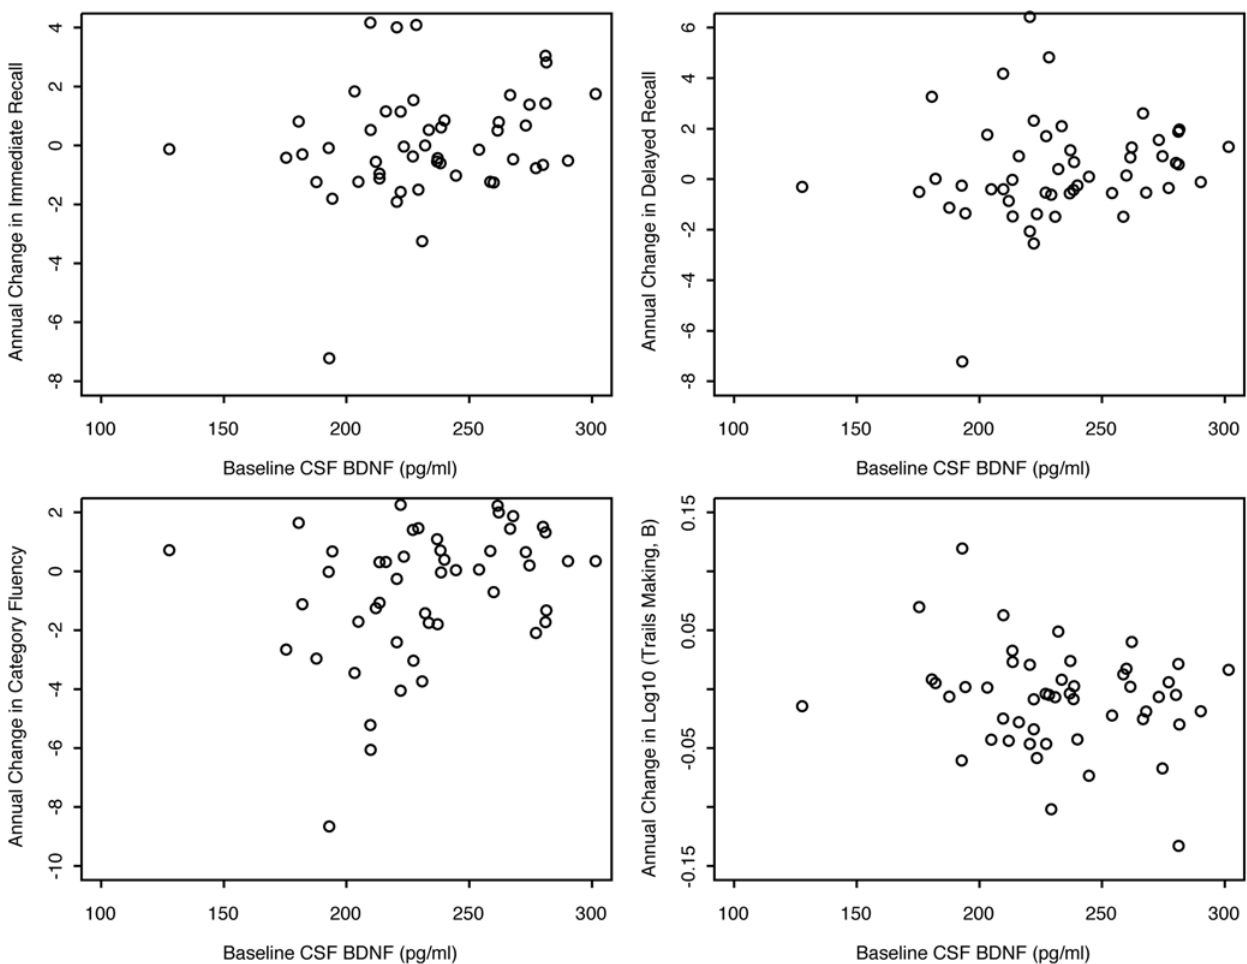
Figure 2. Annual change in cognitive test scores versus baseline CSF BDNF concentration.